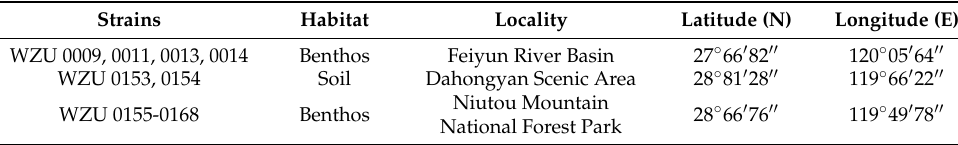
Table 1. Locality and habitat where the cyanobacterial strains in this study were collected. Strains Habitat Locality Latitude (N) Longitude (E) WZU 0009, 0011, 0013,